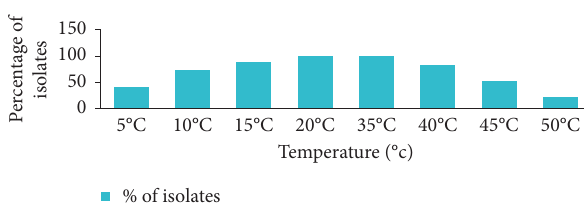
Figure 6: Temperature tolerance of chickpea rhizobia.